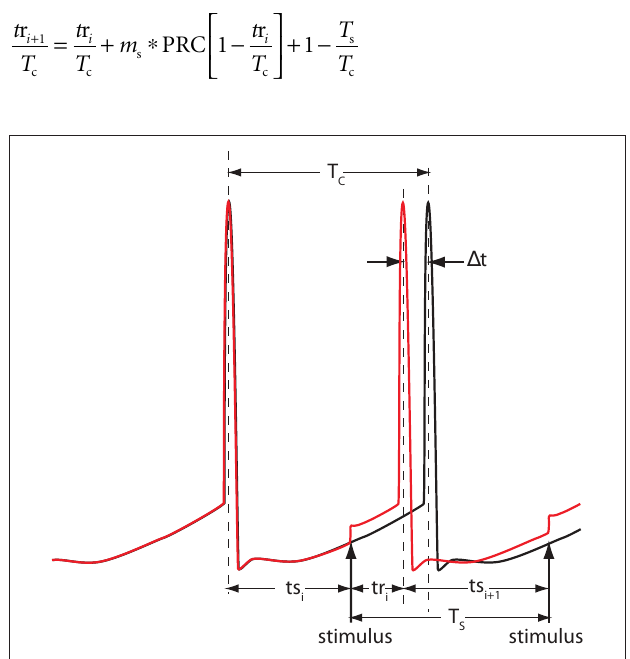
Figure 1 | Notation. Two trajectories of a spontaneously active neuron firing with period T are shown, one unperturbed (black) and one perturbed by the c stimulus presented at period T . The phase-dependent change in the period s caused by the stimulus is ∆ t . Stimulation latencies relative to cell firing are indicated by t s, and response latencies relative to the stimulus are labeled